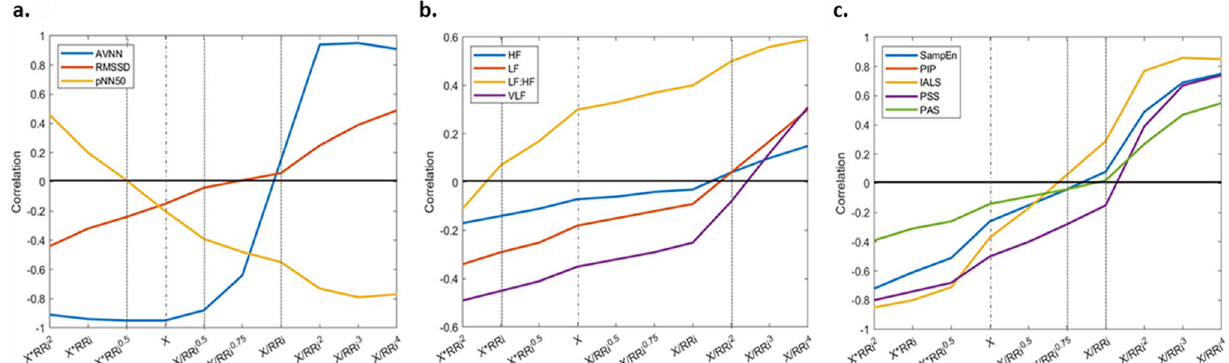
Figure 1. Correlation coefficients between the HRV indices and HR. Correlation coefficients between HRV features and HR are presented for standard and corrected HRV. The X denotes standard HRV indices which are all inversely associated with HR. Multiplication/division by different powers of the corresponding average RR intervals (RRi) were used to correct the standard HRV measures. The dotted lines show the correlation coefficient at X, the uncorrected HRV measures and at the corresponding power used to multiply/divide HRV indices to correct them. ( a ) The correlation coefficients for the time domain features AVNN, RMSSD and pNN50 are shown. ( b ) The correlation coefficients for the spectral indices of HRV HF, LF, LF:HF and VLF are presented. ( c ) The correlation coefficients for sample entropy and the fragmentation measures, PIP, IALS, PSS and PAS are